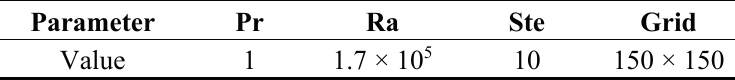
Table 1. The melting benchmark parameters as in